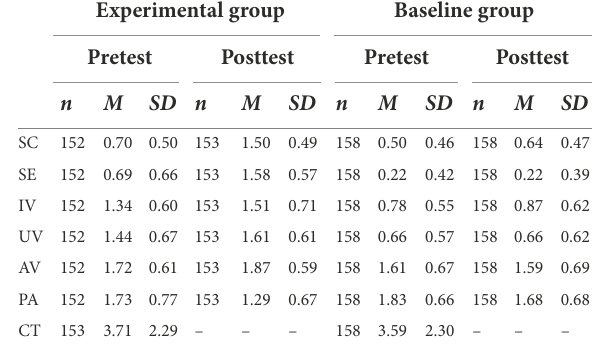
TABLE 2 Descriptive statistics by condition and point of